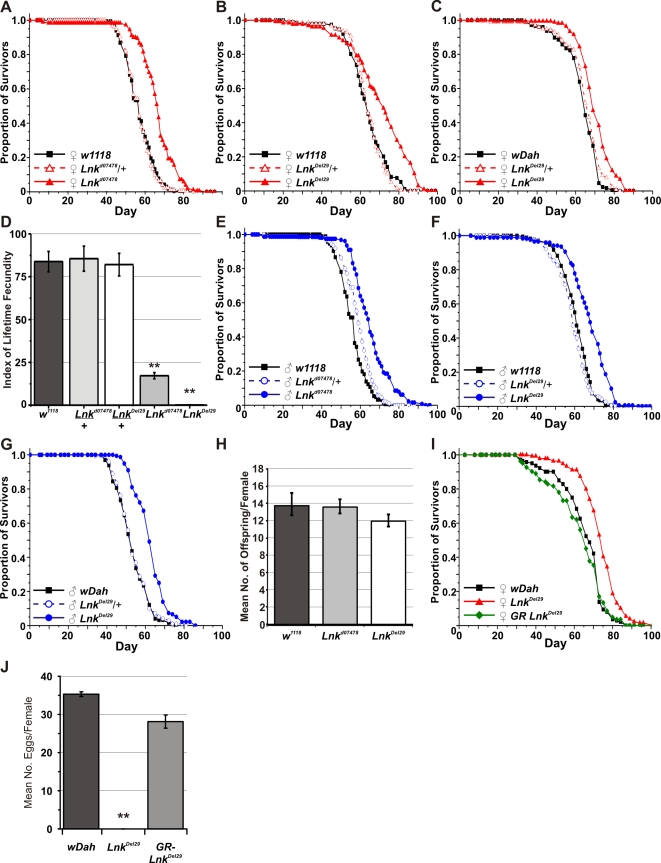
Mutation of Lnk extends lifespan in both sexes and reduces female fecundity.(A) w1118-backcrossed females. Median lifespans are: 57 days for w1118 (n = 196), 58 days for Lnkd07478/+ (n = 203) and 65 days for Lnkd07478/Lnkd07478 (n = 163). Log rank test χ2 and p-values: w1118 versus Lnkd07478/+ (χ2 = 1.7, p = 0.192) and w1118 versus Lnkd07478/Lnkd07478 (χ2 = 90.2 , p<0.0001). (B) w1118-backcrossed females. Median lifespans are 61 days for w1118 (n = 173), 59 days for LnkDel29/+ (n = 200) and 68 days for LnkDel29/LnkDel29 (n = 182). Log rank test χ2 and p-values: w1118 versus LnkDel29/+ (χ2 = 2.2, p = 0.139) and w1118 versus LnkDel29/LnkDel29 (χ2 = 65.2, p<0.0001). (C) wDah-backcrossed females. Median lifespans are 63 days for wDah (n = 179), 66 days for LnkDel29/+ (n = 177) and 68 days for LnkDel29/LnkDel29 (n = 178). Log rank test χ2 and p-values: wDah versus LnkDel29/+ (χ2 = 4.67, p = 0.03) and wDah versus LnkDel29/LnkDel29 (χ2 = 53.09, p<0.0001). (D) Reduced fecundity in Lnk homozygous mutant females. Index of lifetime fecundity represents the mean number of eggs laid per female per day at 10 time points during the first 40 days of life. Index of lifetime fecundity in Lnk homozygous mutant females (white bars) is significantly reduced compared to control flies (w1118; dark grey bars) and heterozygotes (light grey bars). Data are shown as means ±SEM. ** denotes statistically significant difference (p<0.05). (E) w1118-backcrossed males. Median lifespans are 57 days for w1118 (n = 198), 57 days for Lnkd07478/+ (n = 196) and 67 days for Lnkd07478/Lnkd07478 (n = 190). Log rank test χ2 and p-values: w1118 versus Lnkd07478/+ (χ2 = 0.1 , p = 0.778) and w1118 versus Lnkd07478/Lnkd07478 (χ2 = 107.0, p<0.0001). (F) w1118-backcrossed males. Median lifespans are 63 days for w1118 (n = 192), 63 days for LnkDel29/+ (n = 181) and 71 days for LnkDel29/LnkDel29 (n = 144). Log rank test χ2 and p-values: w1118 versus LnkDel29/+ (χ2 = 0.5, p = 0.463) and w1118 versus LnkDel29/LnkDel29 (χ2 = 37.0, p<0.0001). (G) wDah-backcrossed males. Median lifespans are 52 days for wDah (n = 169), 52 days for LnkDel29/+ (n = 168) and 61 days for LnkDel29/LnkDel29 (n = 171). Log rank test χ2 and p-values: wDah versus LnkDel29/+ (χ2 = 0.24, p = 0.627) and wDah versus LnkDel29/LnkDel29 (χ2 = 44.89, p<0.0001). (H) Mean number of eggs laid per w1118 female crossed to males of the indicated genotype. Data are shown as mean number of eggs laid per female fly over a four day period ± SEM. (I) Genomic rescue (GR) of Lnk in wDah-backcrossed females. Median lifespans are 67 days for wDah (n = 151), 74 days for LnkDel29/LnkDel29 (n = 150) and 66 days for LnkGR;LnkDel29/LnkDel29 (n = 92). Log rank test χ2 and p-values: wDah versus LnkDel29/LnkDel29 (χ2 = 33.87, p<0.0001) and wDah versus. LnkGR;LnkDel29/LnkDel29 (χ2 = 0.71, p = 0.40). (J) Genomic rescue of female fertility defects. Eggs were counted on day 7 of the lifespan experiment shown in (I). Data are shown as mean number of eggs/female over a 24 hour period ± SEM. ** denotes statistically significant difference (p<0.05).